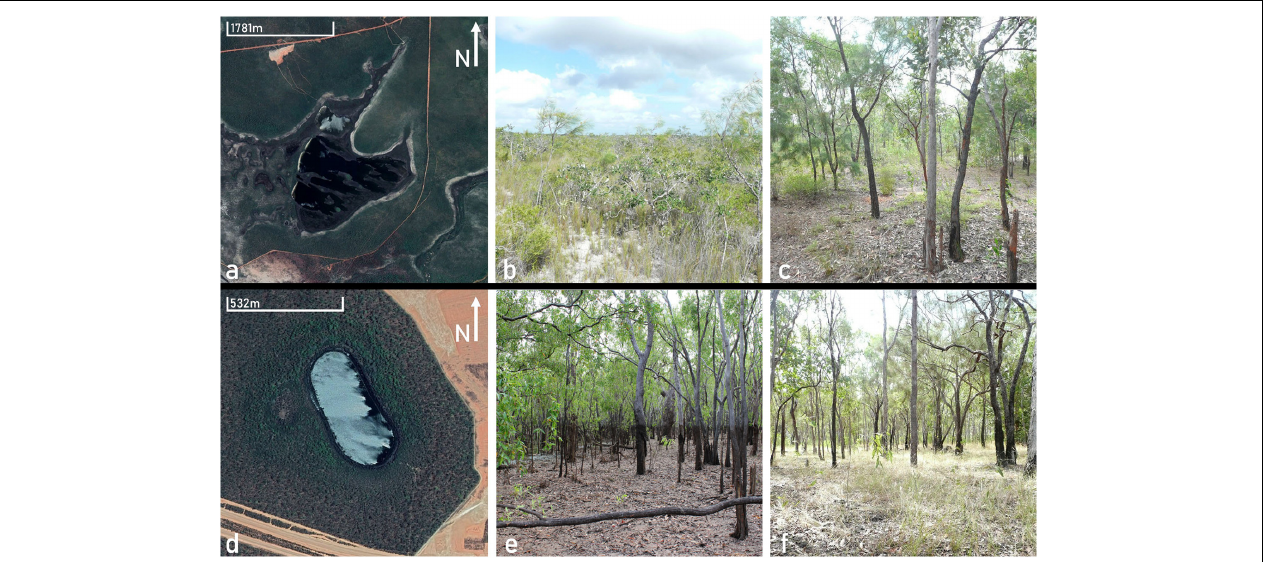
FIGURE 3 | Satellite imagery and on-site photos of sites presented in this study; (a) Sanamere Lagoon satellite image (Google Earth, 2021b), (b) Sanamere Lagoon dwarf heathland vegetation, (c) open woodland vegetation 300 m from Sanamere Lagoon, (d) Big Willum Swamp satellite image (Google Earth, 2021a), (e) open woodland showing the wet season high water mark of Big Willum Swamp, (f) open woodland vegetation with grassy understorey beyond the Big Willum Swamp high waterline.